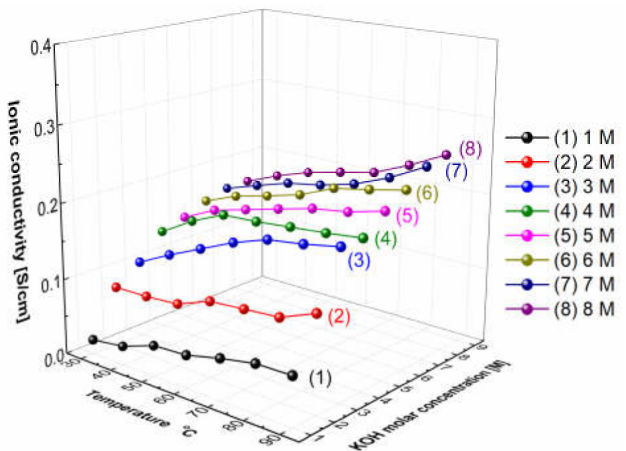
Figure 11. Hydroxide ion conductivity measured using the 4-probe method (Figure 4 mode) without immersing in a KOH condition only installed wetting membranes immersed in 1–8 M KOH before the